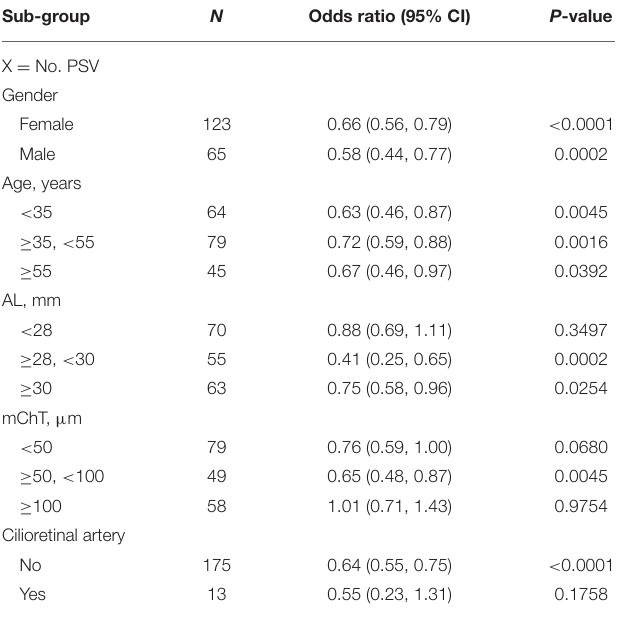
TABLE 5 | Stratified analysis of the association between perforating scleral vessel and myopic neovascular maculopathy. Sub-group N Odds ratio (95% CI)